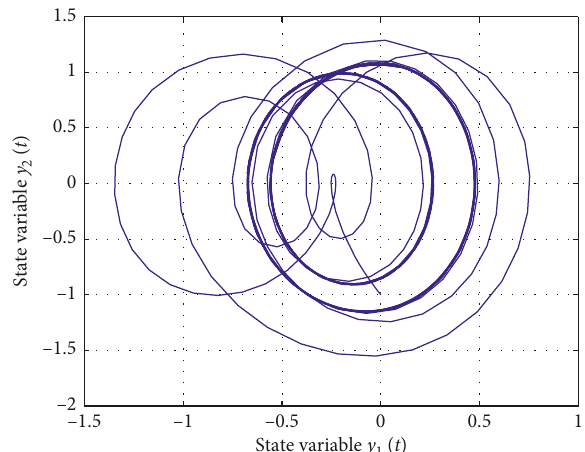
Figure 6: The simulation result for the master system.